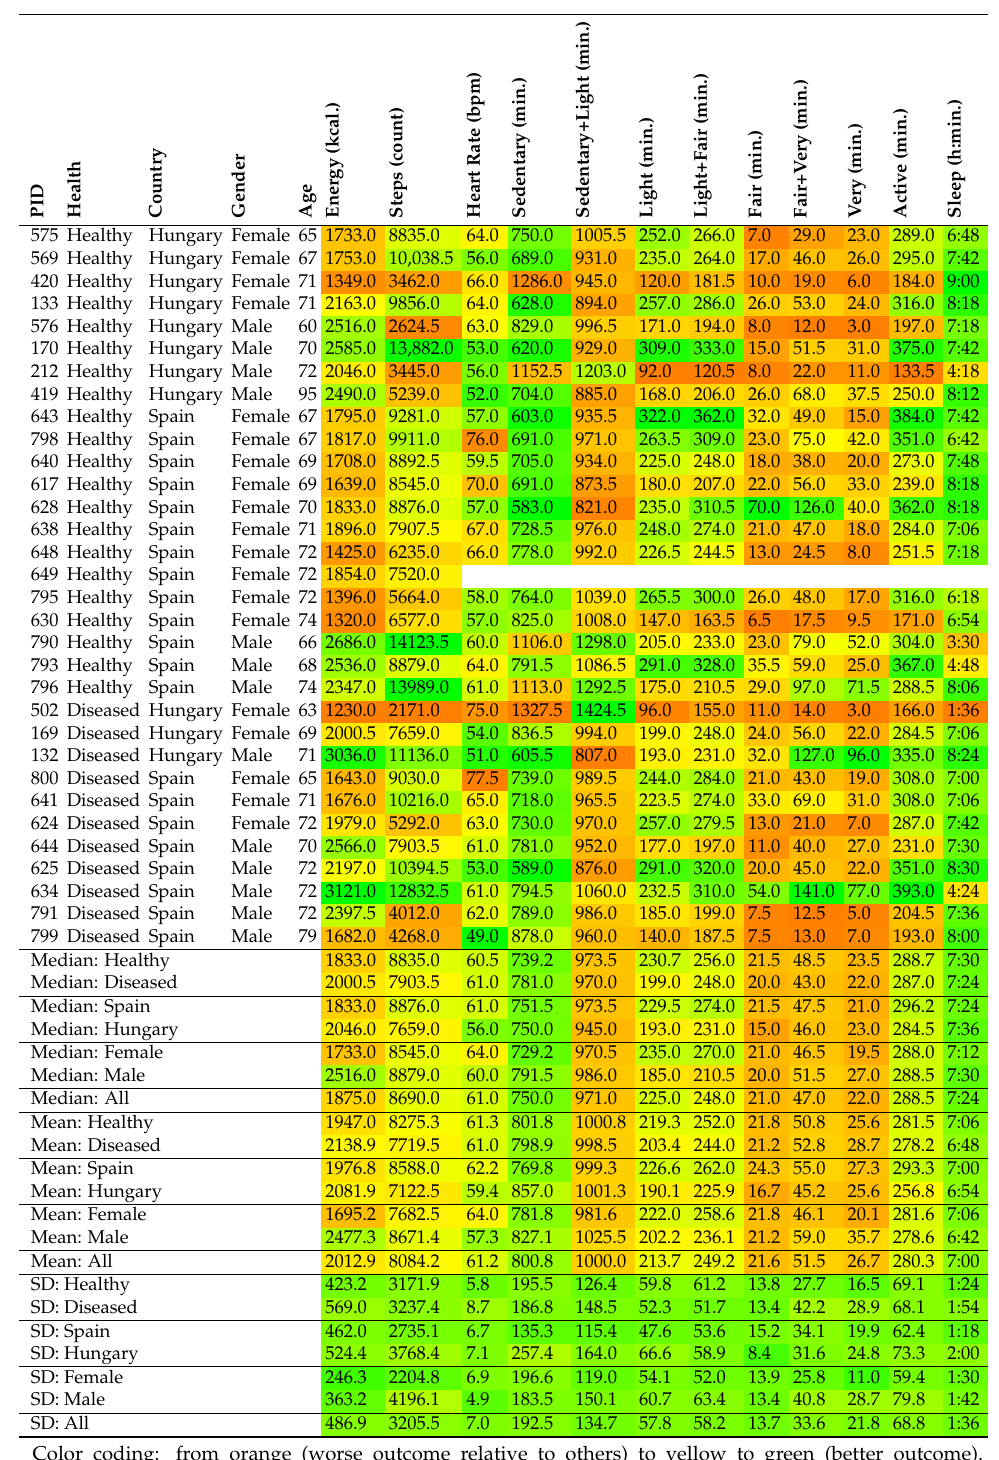
Table A12. Median values of TechROs (Fitbit) across the entire monitoring period ( N = 32 participants).